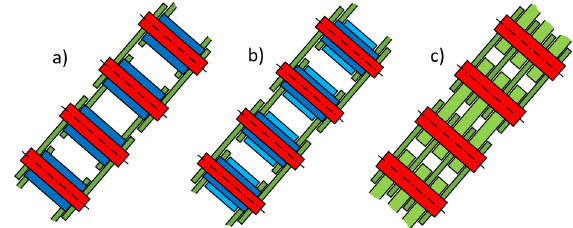
Figure 1. Timing chain types: a) bush chain, b) roller chain, c) toothed chain (silent chain)